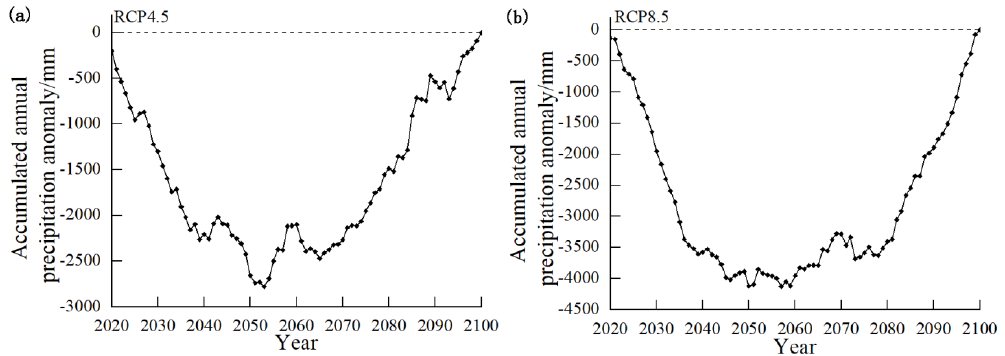
Figure 7. Accumulated annual precipitation anomaly in the Lancang–Mekong River subregion under the RCP4.5 ( a ) and the RCP8.5 ( b ).